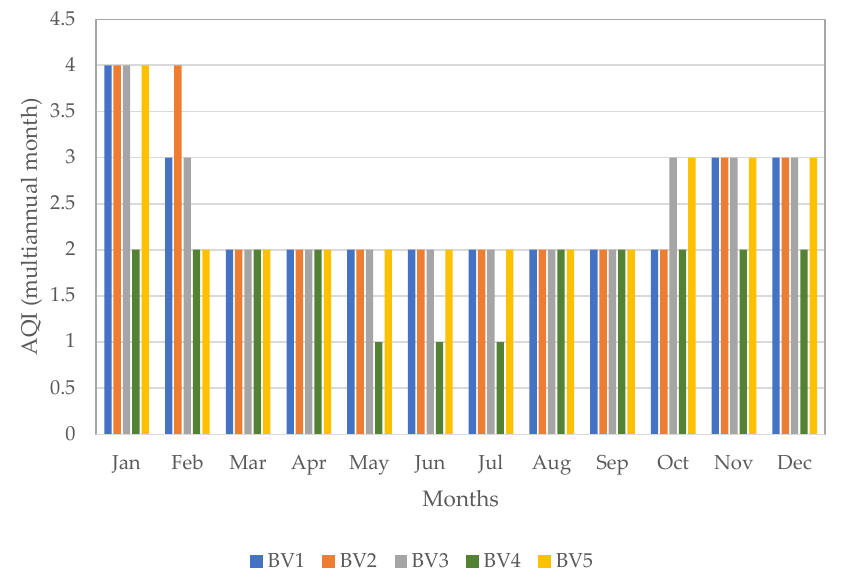
Figure 7. Variation of the multiannual monthly average per station.